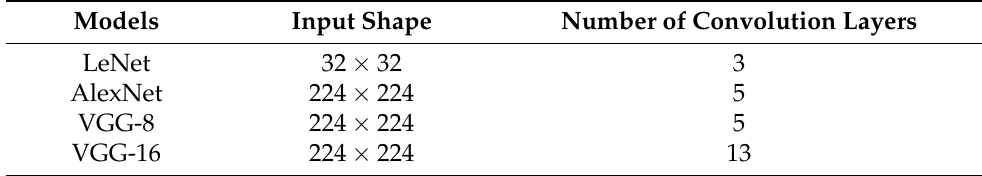
Table 3. Information of DNN